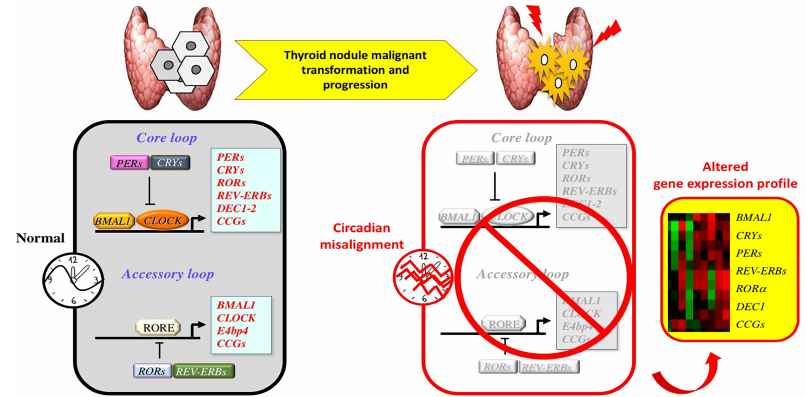
Figure 2. Molecular alterations in circadian clock gene machinery during thyroid nodule malignant transformation and progression. The circadian transcriptional / translation machinery physiologically acts through a core loop in which CLOCK / BMAL1 activate transcription by binding E-boxes in the promoters of target genes ( PERs, CRYs, REV-ERBs , RORs, DECs, WEE1, c-MYC and other clock-controlled genes ( CCGs )). In the same loop, the negative PERs and CRYs proteins multimerize and inhibit CLOCK / BMAL1 activity. Clock machinery is also regulated by an accessory loop, consisting of antagonizing transcription factors such as REV-ERBs ( α − β ) and RORs ( α − β − γ ), which regulate CLOCK / BMAL1 gene expression and CLOCK / BMAL1 -mediated CCGs transcription through ROR-elements (RORE). During thyroid tumorigenesis, circadian misalignment is associated with an altered expression of several clock genes and other CCGs controlling cellular and metabolic